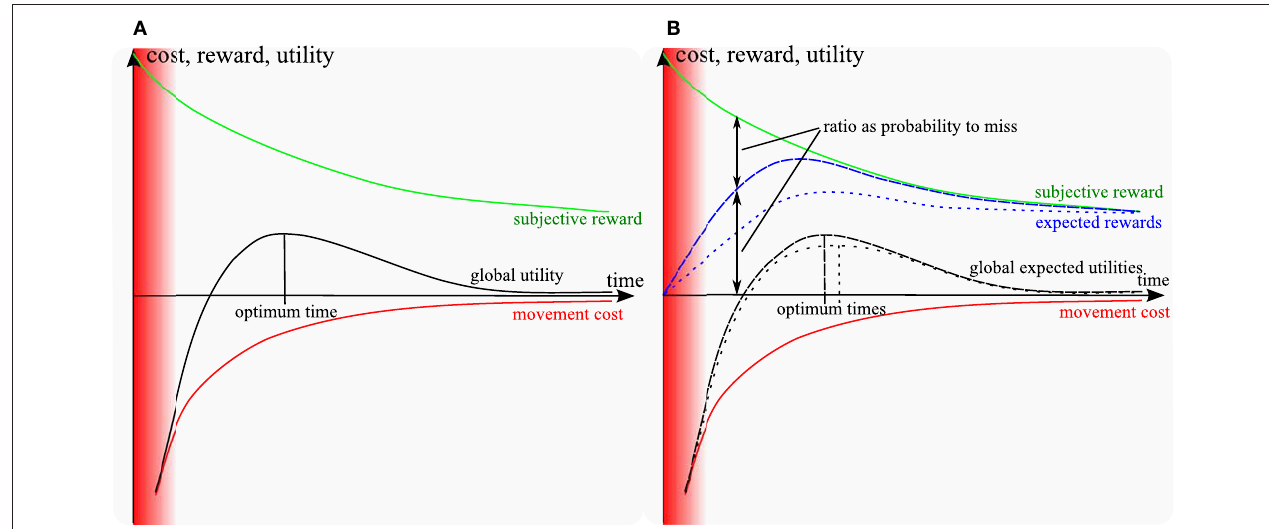
FIGURE 1 | Sketch of models: (A) cost-benefit trade-off models (Shadmehr et al., 2010; Rigoux and Guigon, 2012); (B) including the probability to miss (proposed model). Red area: unfeasible short times. Green: subjective reward of movement; red: muscular energy cost. Blue and black lines: expected rewards and utilities respectively (dashed for a large target, dotted for a small target). In the standard and proposed models, the subjective utility of getting the reward decreases over time, while slow hitting movements require less muscular effort. As a result, the sum of the reward and the (negative) effort cost reaches a maximum for a certain time (optimum time). The expected reward is the probability-weighted average of the subjective reward over infinitely many repetitions. It converges to the blue line as the number of repetitions increase. The same for the global expected utility. In the proposed model, the probability to hit is null for fast movements and converges to 1 as movements slow down. Furthermore, as movement time increases, the probability to hit increases faster for a large target than for a small one. Therefore, the expected reward matches the subjective reward faster for large targets than for small targets and the optimum time (time at the maximum of global expected utility) is shifted toward longer time for smaller targets, as a result of the speed-accuracy trade-off. Besides, at the optimum time, the probability to miss the target is larger for small targets than for large targets. Note that if the target becomes considerably large compared to the length of the movement, it could affect the cost characteristics. Having a larger target width might decrease the expected effort, because of the biomechanics and anisotropy of inertia of the arm. However, in this study we considered relatively small targets compared to the movement